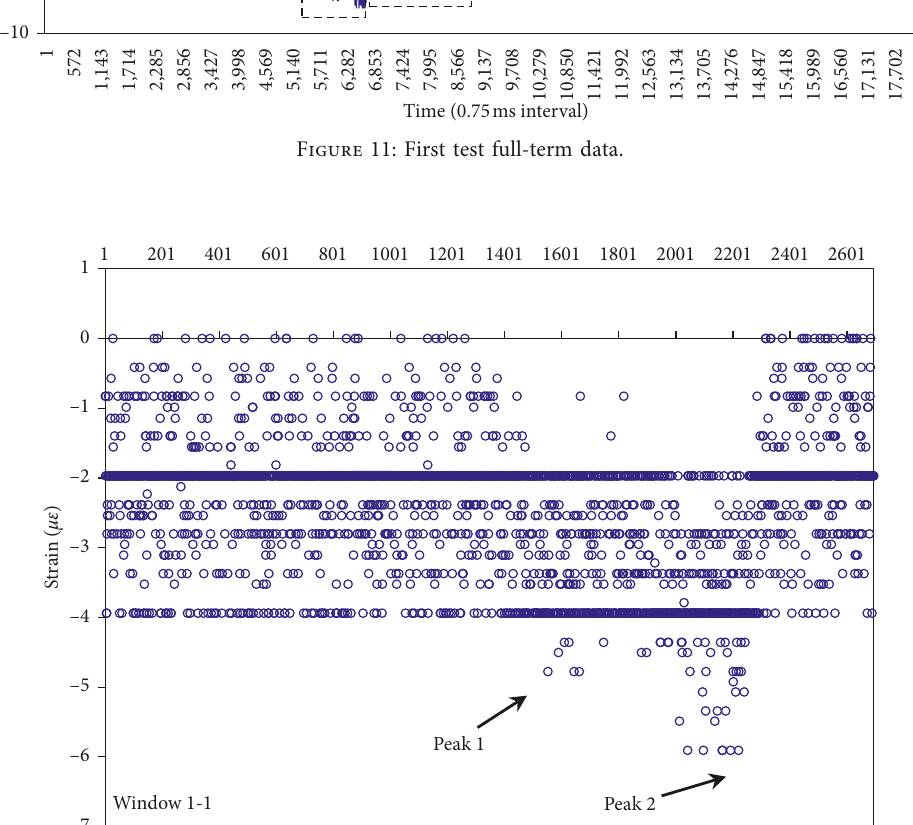
Figure 12: Overpressure phase of the first test.